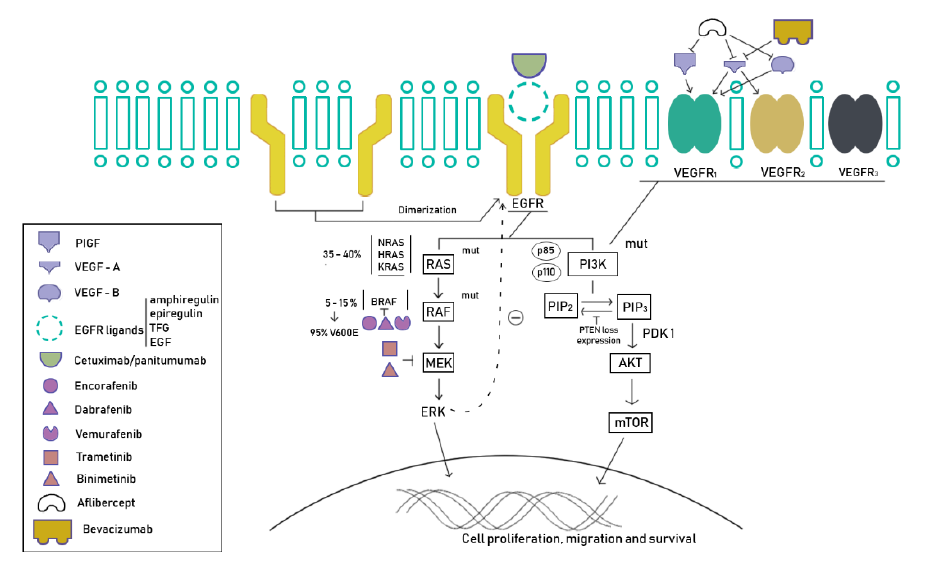
Figure 1. EGFR (epidermal growth factor receptor) and VEGFR (vascular endothelial growth factor receptor) signalization pathways. BRAF plays a central role in this key pathway in colorectal cancer. In the legend is represented the different targeted therapeutic and drugs strategies developed in this setting of patients.